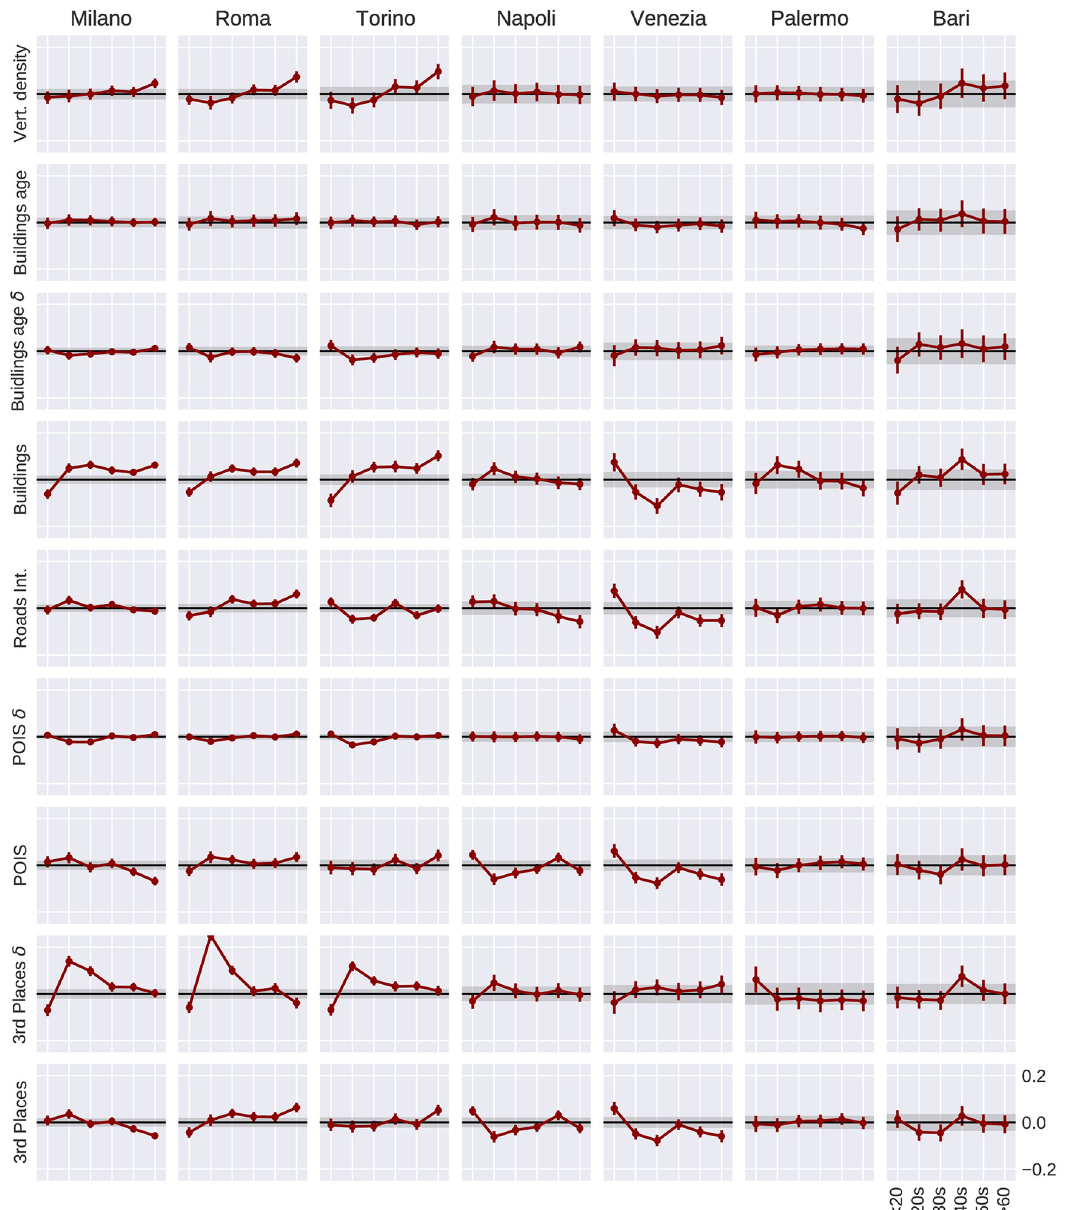
Fig 3. Age group differences in an univariate spatial error model of geographical features. For each city and each age group we run a univariate spatial regression model where the dependent variable Y is the vibrancy, and the independent variable X is one urban feature at a time. We first run the the spatial error model for the aggregate case (all ages) and then subtract the resulting coefficient from each age group. Thus, a positive value for a certain age group indicates that a particular urban feature is relatively more strongly related to the vibrancy compared to the aggregate case. X and Y axes are all the same across small multiples, and labels are only displayed in the bottom-right subplot. Before running the univariate linear model, all values have been standardised subtracting the mean and dividing by the standard deviation. Straight lines along zero indicate no variation across age groups. The error bars are provided by the spatial model result. The grey bands around zero indicate the error of the aggregate value. Milan, Rome and Turin are the cities with higher number of cells (and populations) and more significant patterns. An equivalent plot using the spatial lag model can be found in the S1 File.